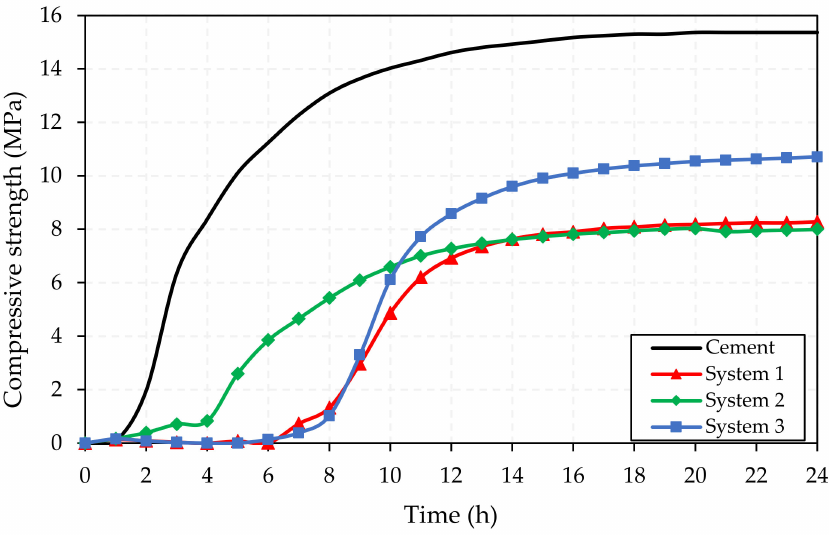
Figure 15. Compressive strength curves for cement slurries contaminated by systems 1, 2 and 3.